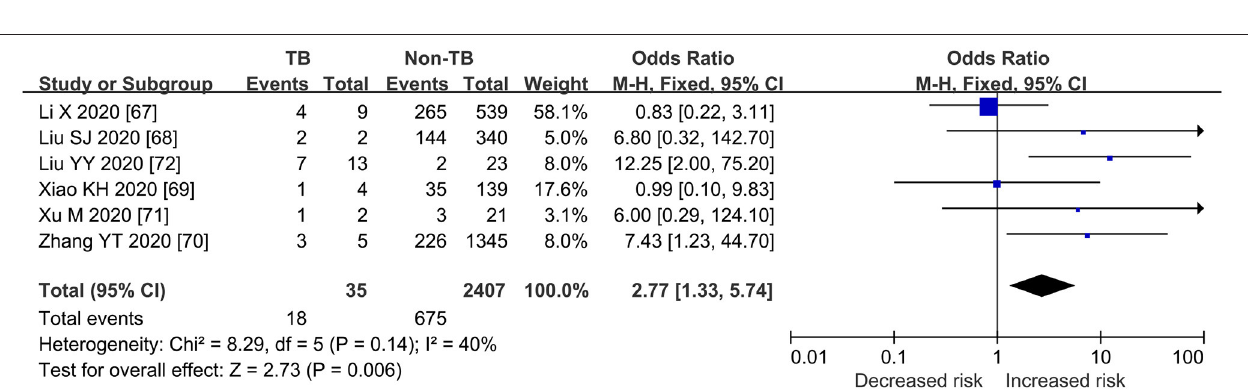
FIGURE 2 | Forrest plot demonstrating the pooled ORs of death in COVID-19 patients with tuberculosis. ORs, odds ratios; TB, tuberculosis; CI, confidence interval; events refer to the occurrence of death.